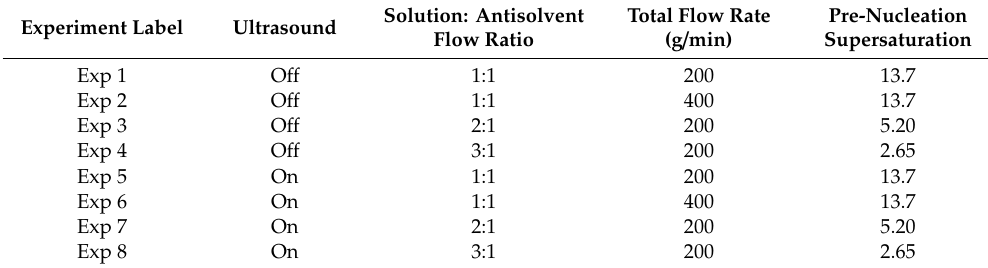
Table 1. Experimental conditions used in the antisolvent crystallisation experiments. Experiment